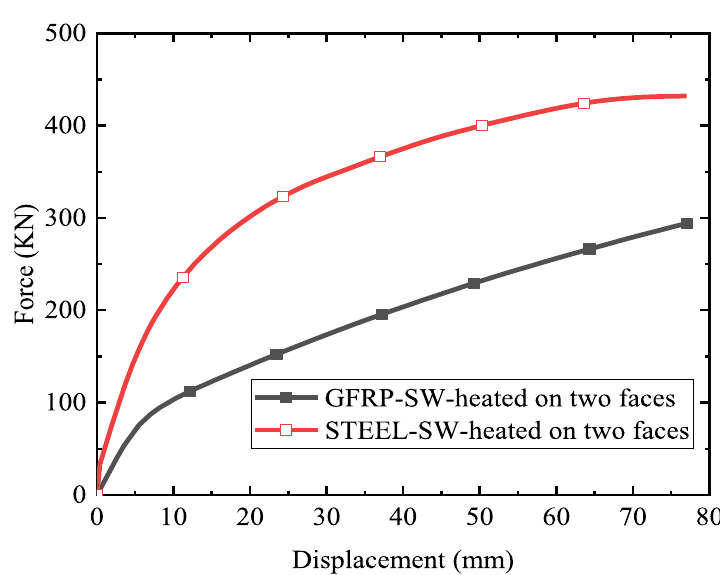
Fig. 44 Load-displacement curve of two faces heated RC shear wall of cover 30